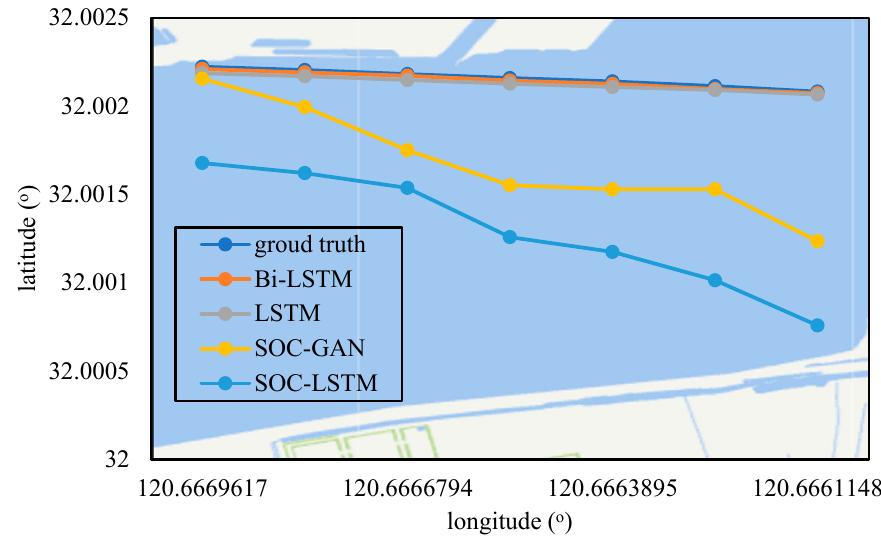
Figure 2. Performance of the ship trajectory prediction segment comparison for different models. Table 4. Ship trajectory segment prediction performance on latitude data samples.